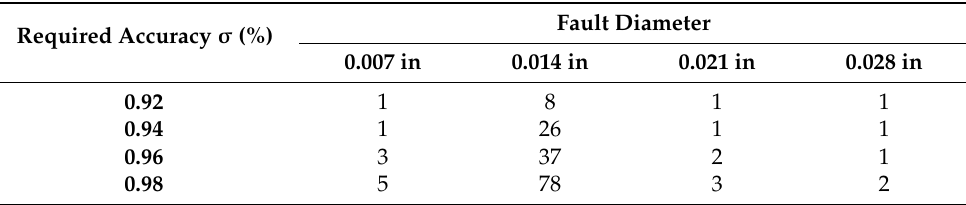
Table 7. The minimum of the sampling number in group